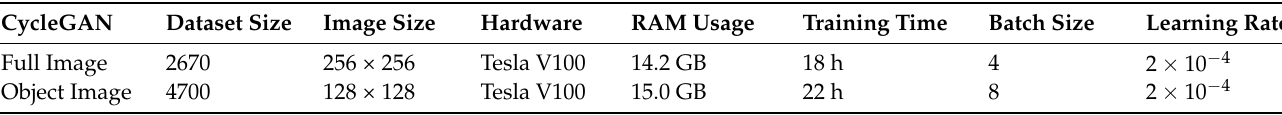
Table 3. UWCycleGAN model experimental details.